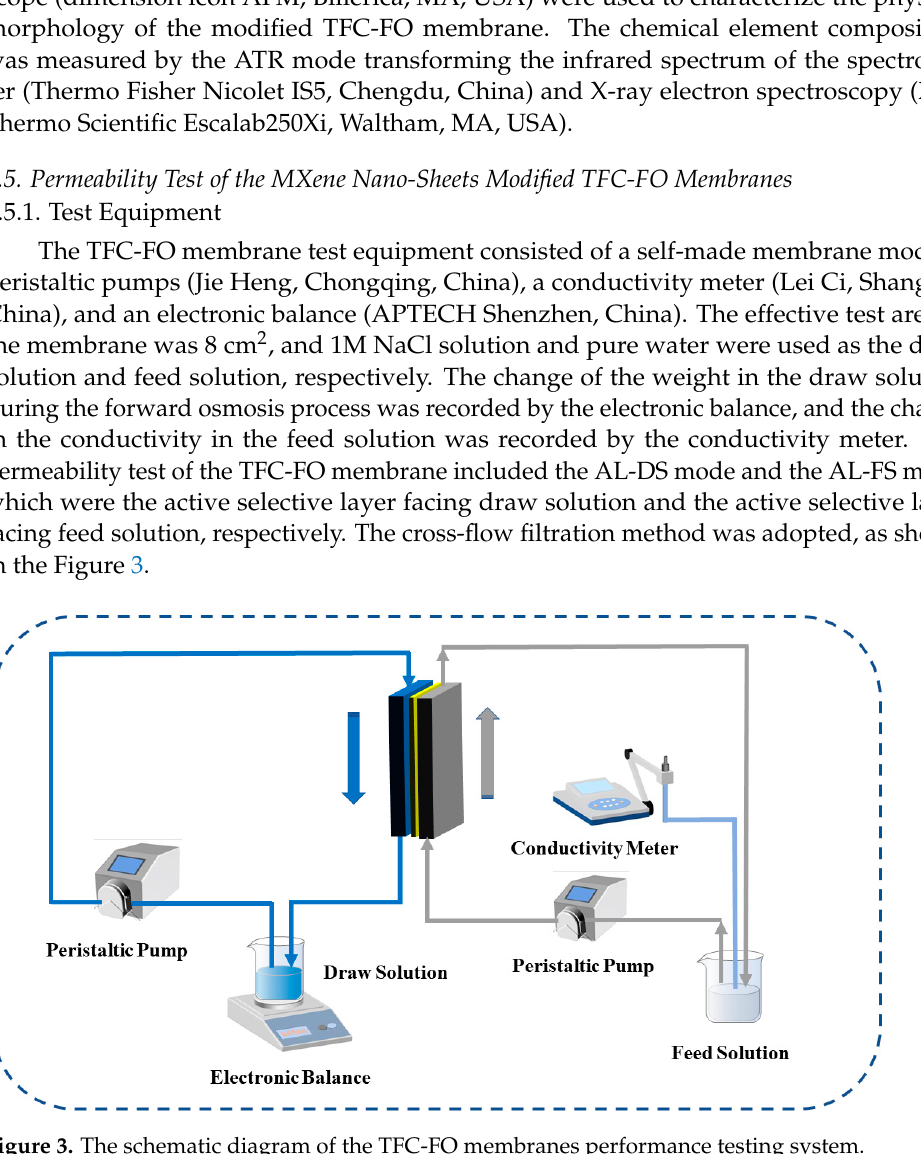
Figure 3. The schematic diagram of the TFC-FO membranes performance testing system.